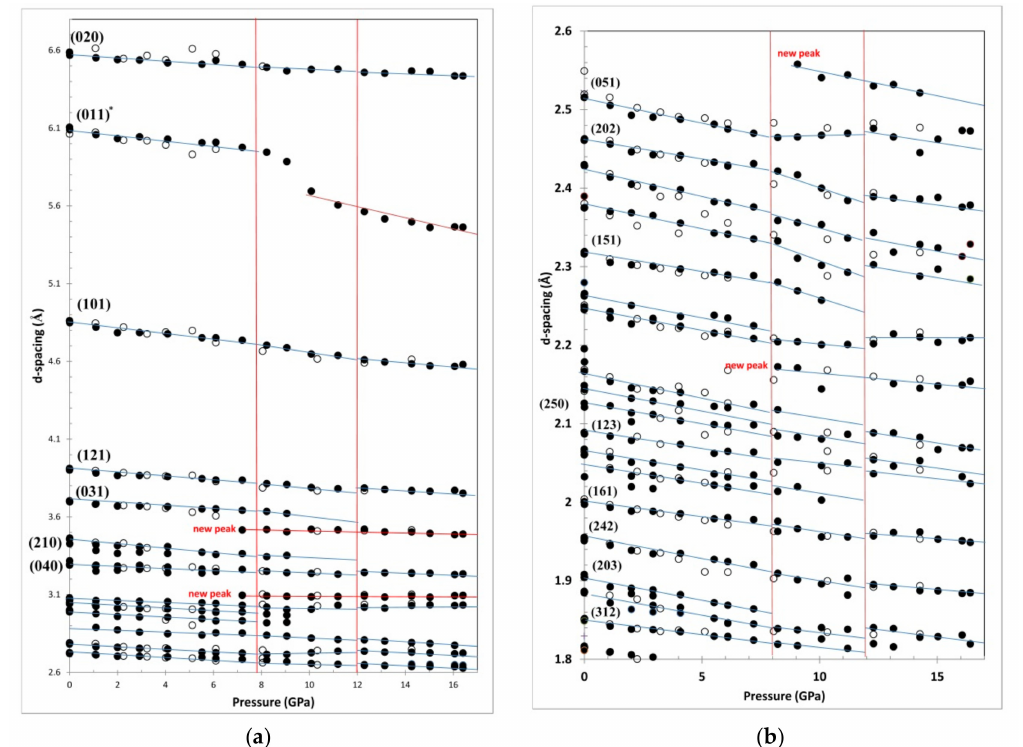
Figure 4. The variations in d-spacing for each diffraction peak in various phase of scottyite. ( a ) 2.6–6.8; ( b ) d-spacing range: 1.8–2.6. (*: Intensity weak, the trend is for reference only; solid circles: loading; open circles: unloading).